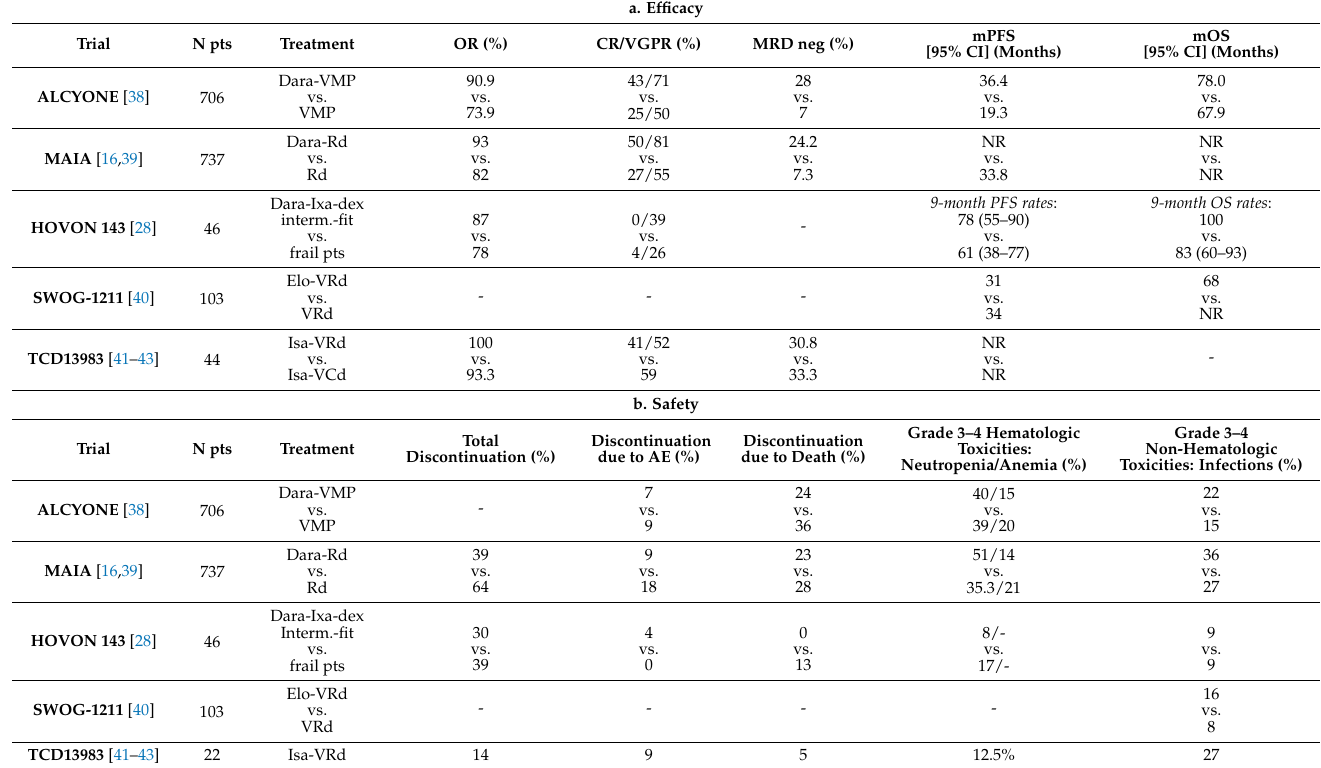
Table 1. Data about efficacy and safety of mAb-based treatments in NTE NDMM